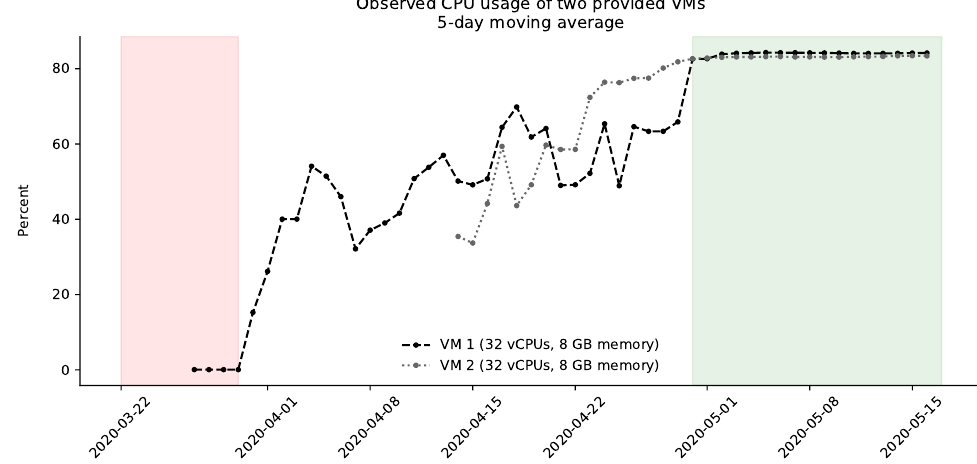
Figure 2. Example usage data of two virtual machines provided to the Folding@home project (compiled from our own data); red area: overload of master nodes, white area: recovering phase, green area: normal